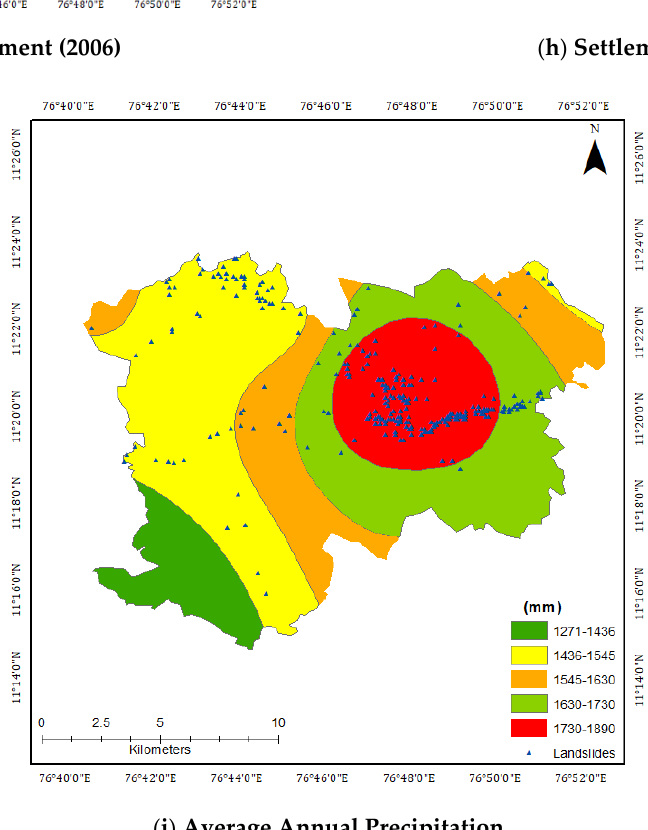
Figure 2. Spatial Databases of Factors Causing Landslides in Coonoor, Tamil Nadu. ( a ) Aspect ( b ) Slope ( c ) Relative Relief ( d ) Topographic Wetness Index-TWI ( e ) Soil ( f ) Land Use ( g ) Settlement-2006 ( h ) Settlement-2016 ( i ) Average Annual Precipitation.